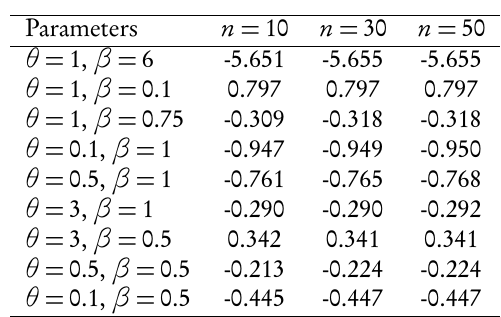
Biases of (cid:98) β .